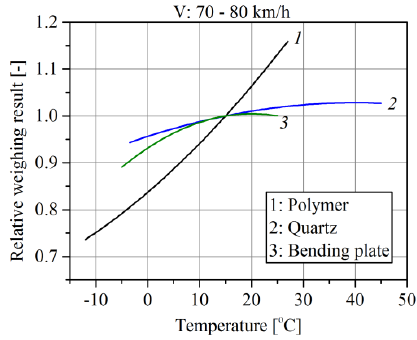
Figure 1. Impact of temperature on vehicle weighing error in Weigh-In-Motion (WIM) systems equipped with sensors manufactured in different technologies.